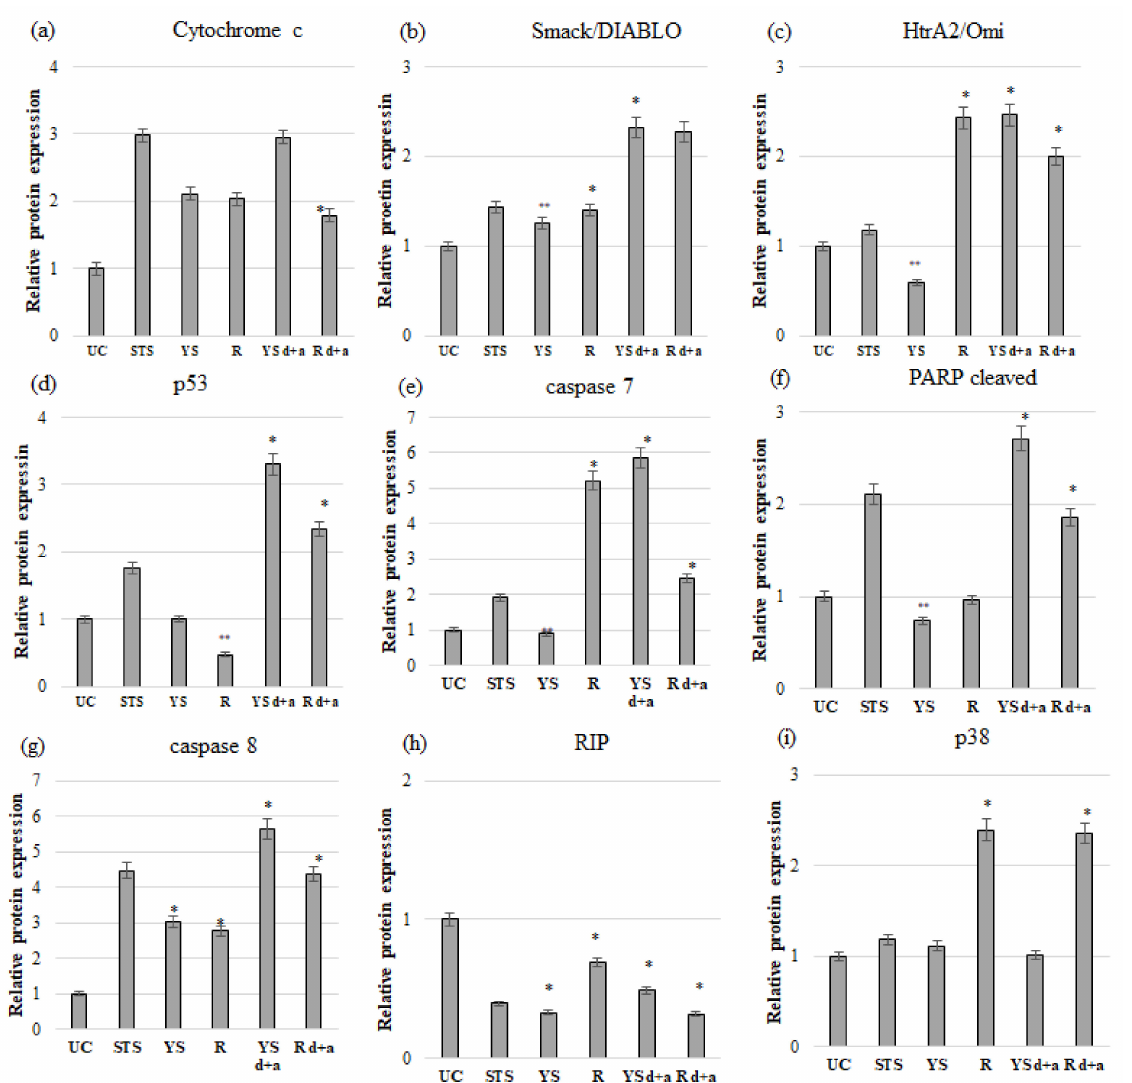
Figure 3. Expression of selected apoptosis-related proteins in MCF-7 cancer cell line. UC—untreated control, STS—staurosporine, YS—native juice of young shoots of beetroot, R—native juice of beet- root, YS d+a—juice of young shoots of red beet subjected to in vitro gastrointestinal digestion